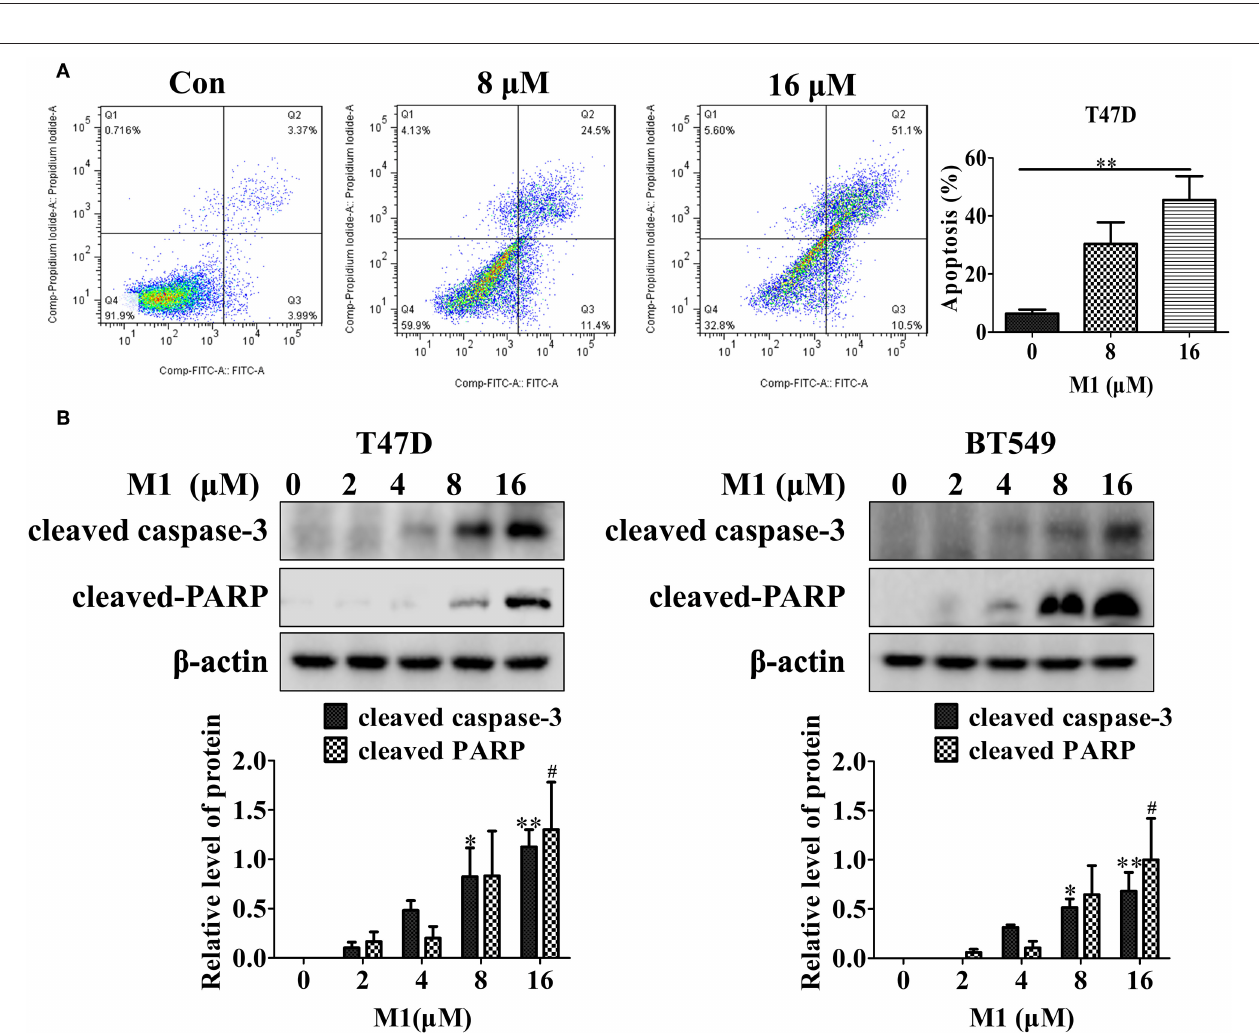
FIGURE 9 | Compound M1 induces apoptosis in breast cancer cells. (A) T47D cells were treated with different concentrations of compound M1 for 48h, and apoptosis was measured by Annexin V-FITC and PI staining. Compound M1 vs. control, * p < 0.05, ** p < 0.01, student t -test, n = 3, means ± SE. (B) T47D and BT549 cells were treated with different doses of compound M1 for 48h, and the levels of cleaved caspase-3 and cleaved PARP were measured by western blotting. β -actin was shown as a loading control. Compound M1 vs. control, * p < 0.05, ** p < 0.01, # p < 0.05 student t -test, n = 3, means ±